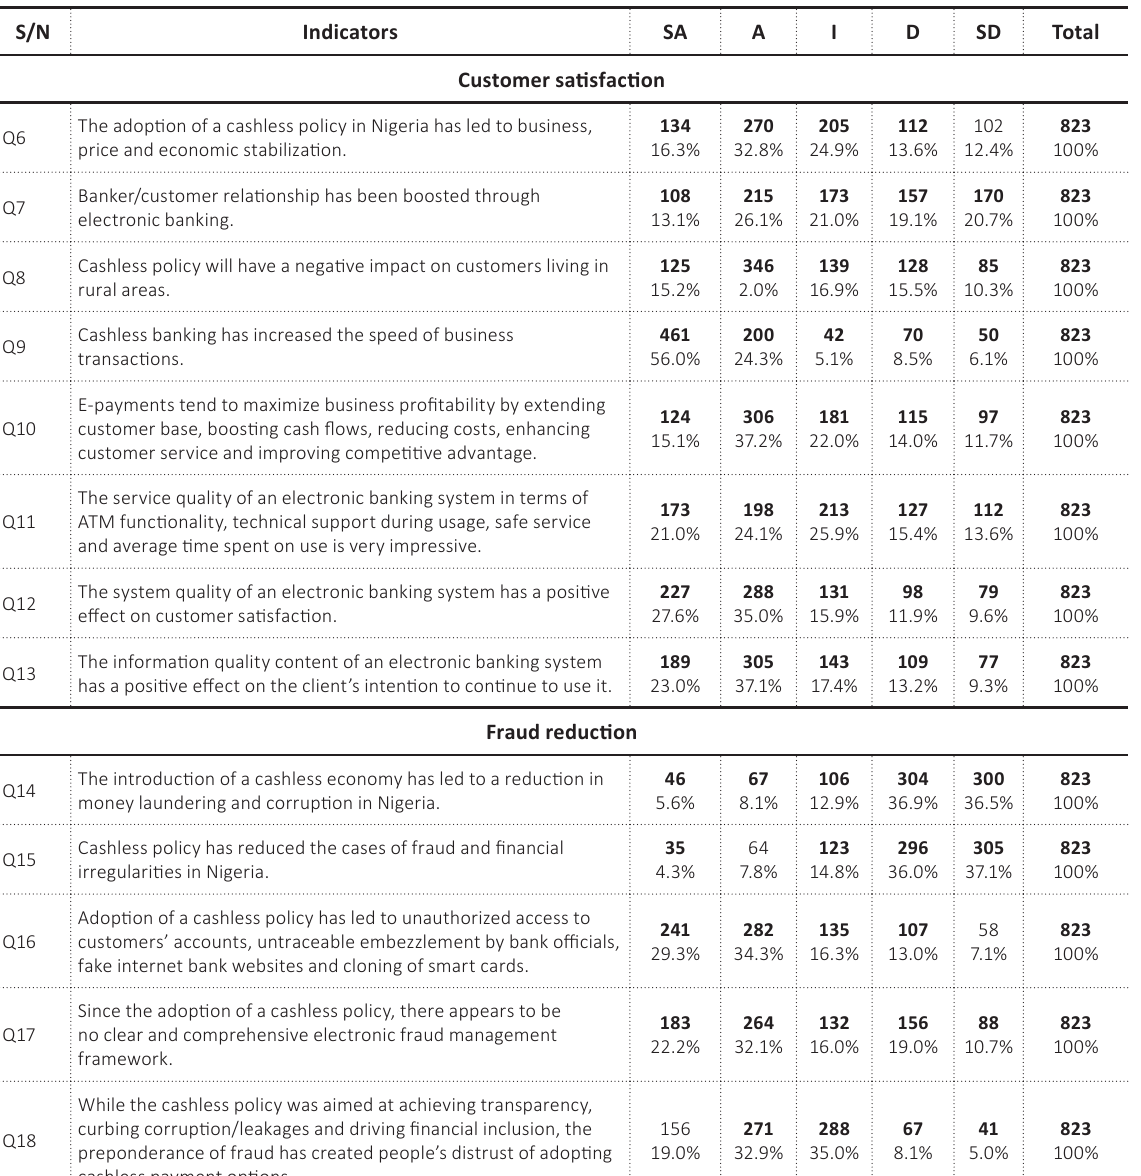
Source: Field survey,